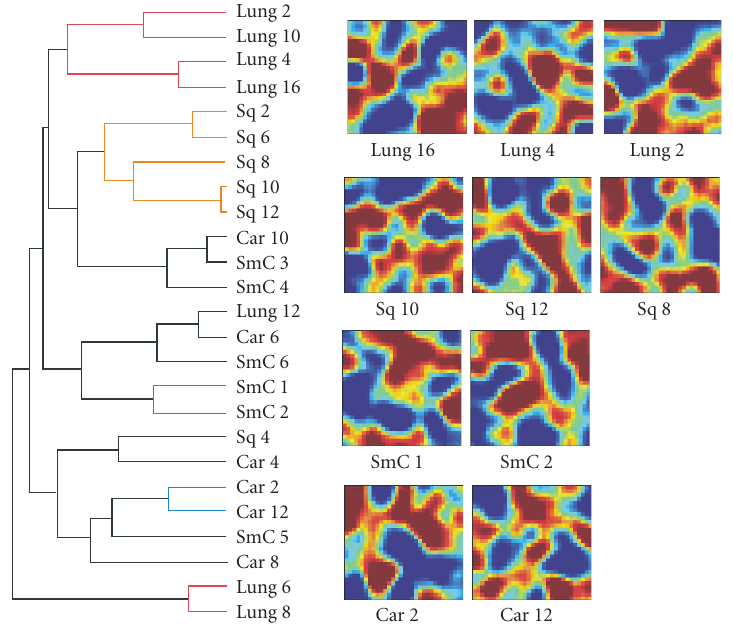
Figure 2: A hierarchical dendrogram computed from the same data as in Figure 1, but with randomly permutated genes. Mixed tissue types can be seen in the same branches of the tree. On the right, random patterns in GEDI maps from three representative samples of each tissue